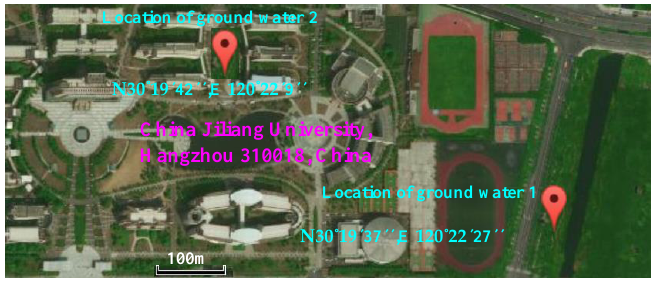
Figure 1. The location of ground water 1 and water 2.